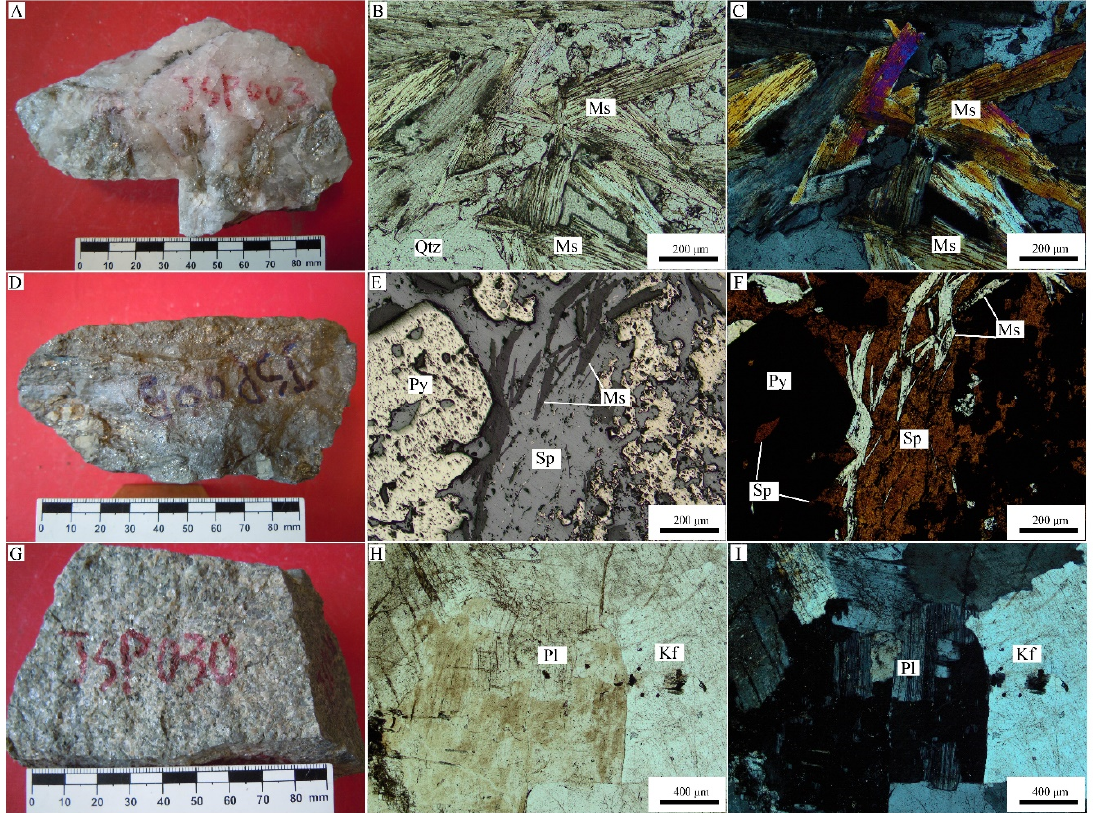
Figure 4. Petrographic characteristics of analyzed ore samples JSP003, JSP005, and JSP030 from the post-mineralization biotite K-feldspar granite at the Jiashengpan deposit. ( A ) Syn-ore quartz vein, hand specimen (sample JSP003); ( B ) hydrothermal quartz coexisting with muscovite, plane-polarized light (JSP003); ( C ) the same field of view as shown in ( B ), cross-polarized light; ( D ) zinc-lead ore, hand specimen (sample JSP005); ( E ) syn-ore hydrothermal muscovite coexisting with hydrothermal sphalerite, reflected light (JSP005); ( F ) the same field of view as shown in ( E ), plane-polarized light (JSP005); ( G ) biotite K-feldspar granite, hand specimen (sample JSP030); ( H ) feldspar and plagioclase are coexistent, plane-polarized light (JSP030); ( I ) the same field of view as shown in ( H ), cross-polarized light (JSP030). Abbreviations: Qtz = quartz, Py = pyrite, Ms = muscovite, Sp = sphalerite, Kf = feldspar, and Pl = plagioclase.